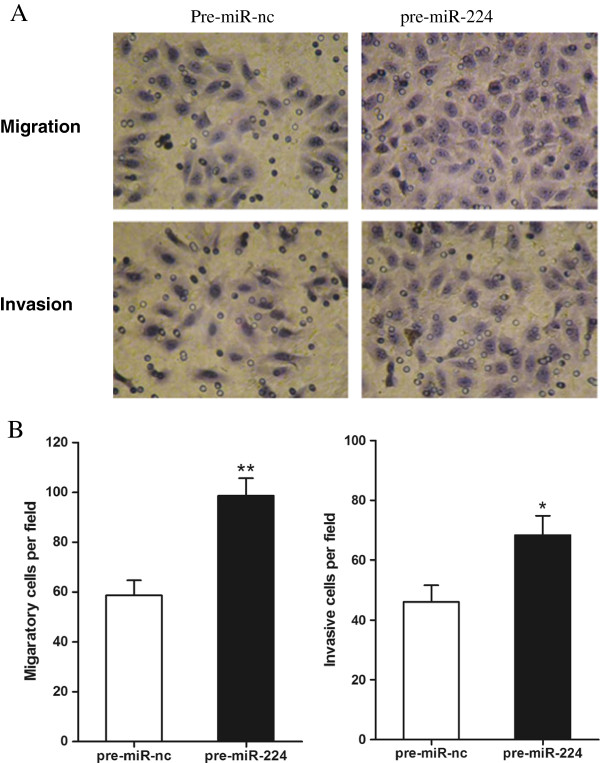
MiR-224 promotes migration and invation of CRC cells in vitro. (A) Representative photographs of migratory cells on the membrane of transwell chambers in migration and invasion assays (magnification, ×400). (B) The number of migratory/invasive cells was counted per field. *P<0.05, **P<0.01.